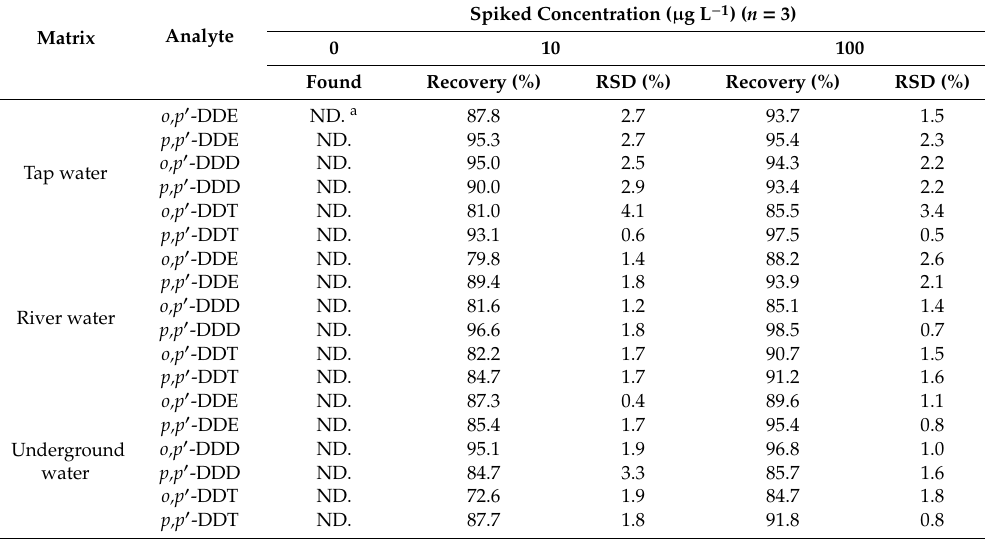
Table 3. Analytical results for determination of DDTs in real water samples.